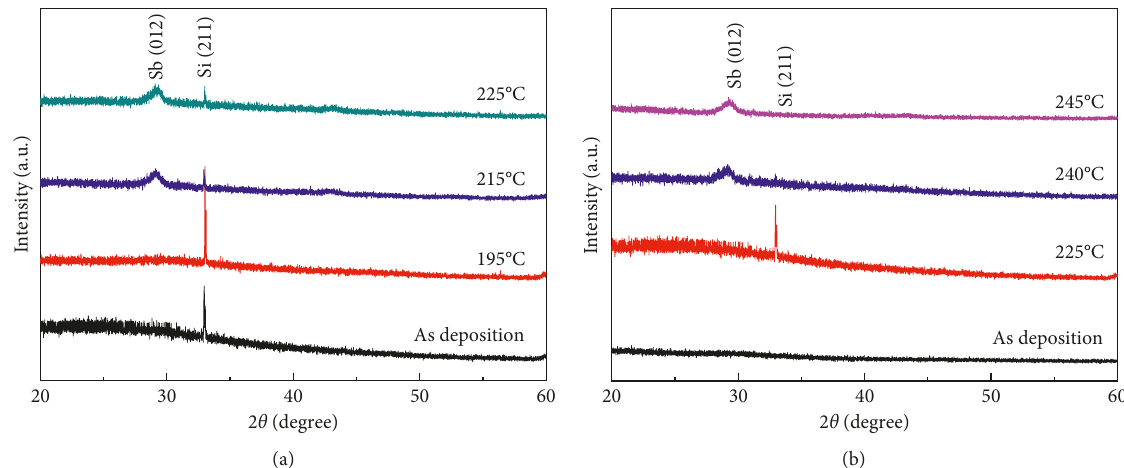
Figure 4: XRD patterns of thin films annealed at different temperatures for 10min in Ar atmosphere: (a) SbSe and (b) SbSe (1 nm) SiO (9nm).